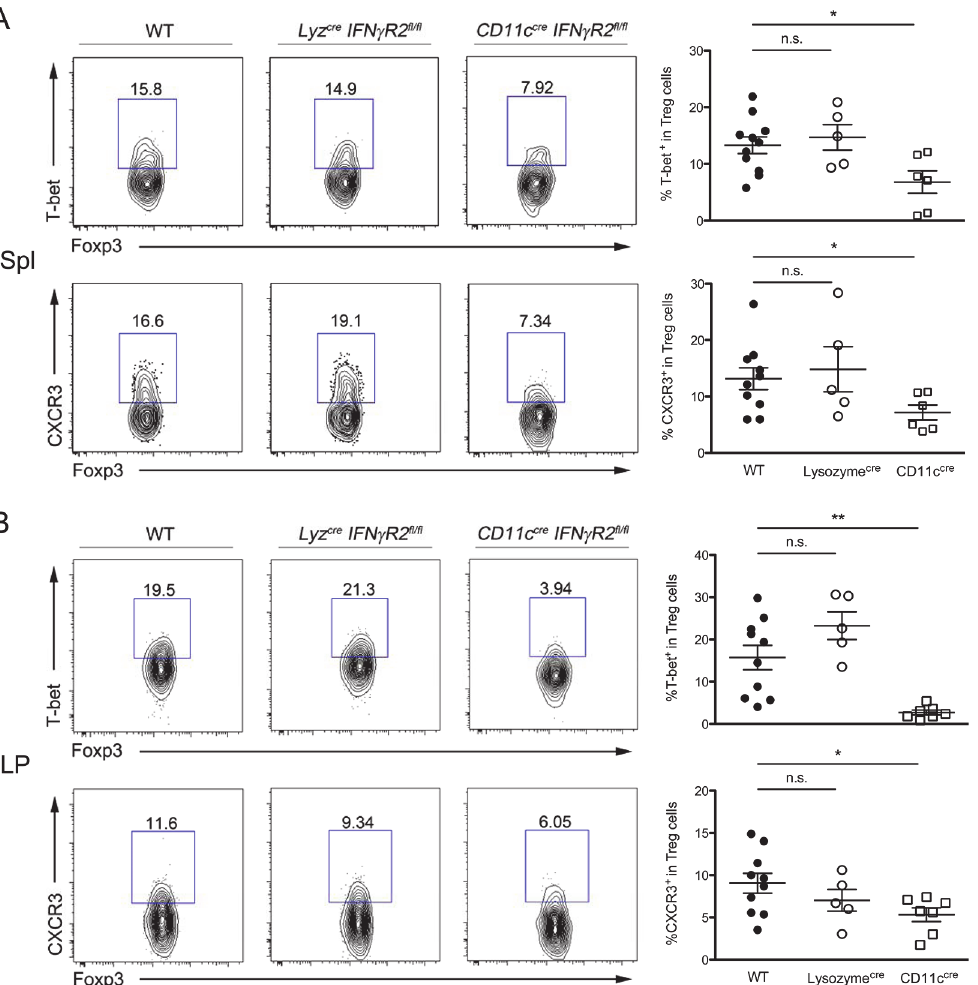
Fig 2. IFN γ signaling in CD11c + DCs, but not myeloid cells, is required for the development of Th1-Treg cells. FACS analysis and frequencies of T- bet + or CXCR3 + cells in Foxp3 + CD4 + Treg cells in (A) Spl and (B) LP isolated from CD11c cre IFN γ R2 fl/fl , Lyz cre IFN γ R2 fl/fl and WT control mice. FACS data are representative of four independent experiments ( * p < 0.05; ** p <